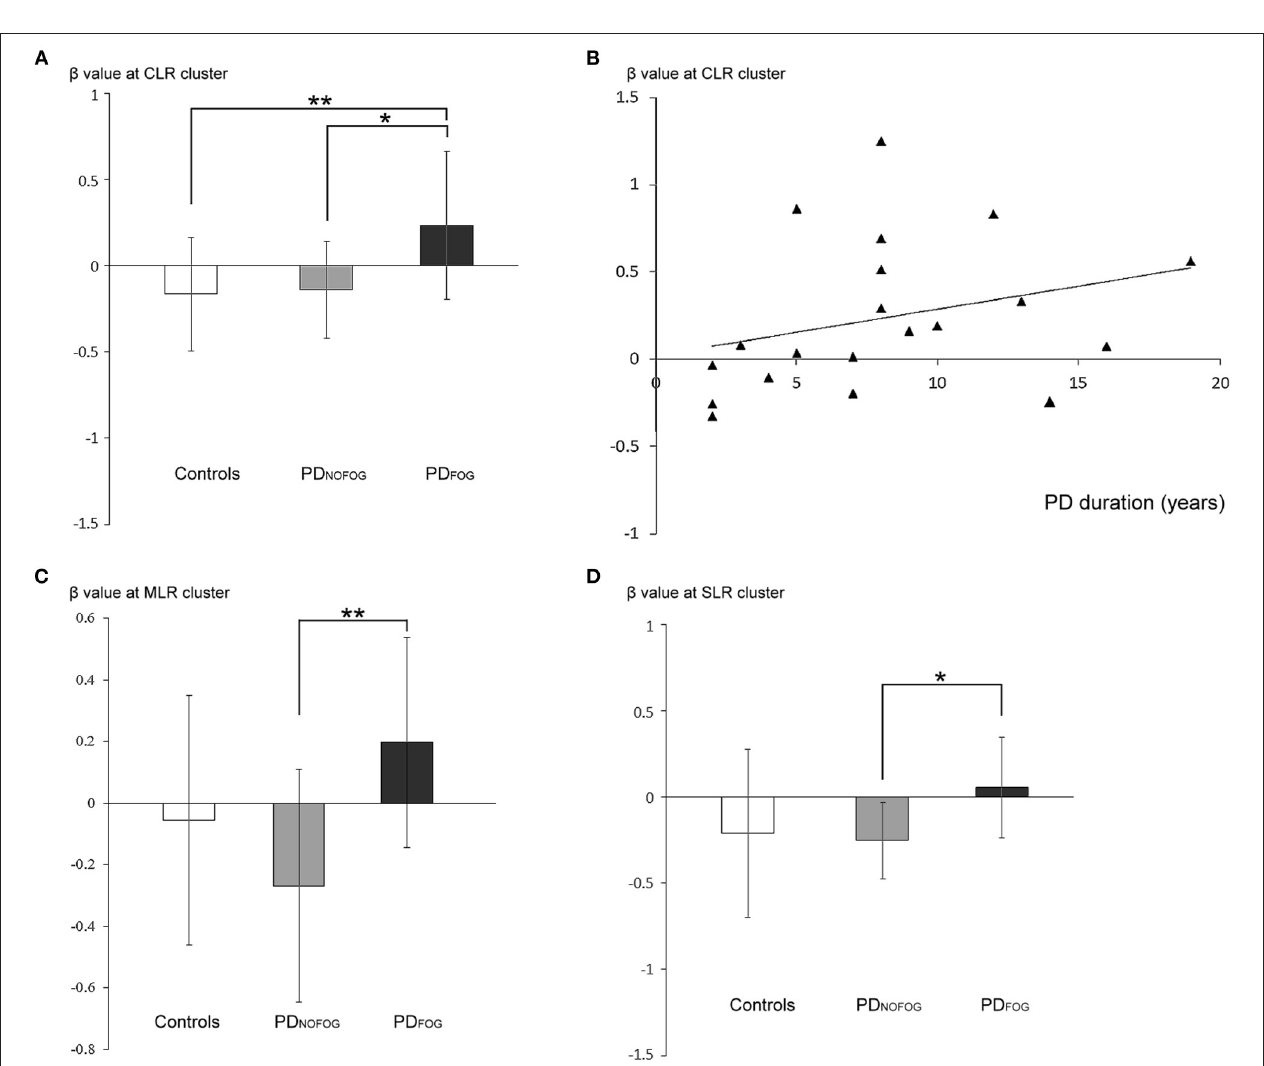
FIGURE 4 | (A) β -weights of the contrast between normal turning and standing (mean ± standard deviation) from the cerebellar locomotor region (CLR) clusters in normal controls, PD NOFOG , and PD FOG . (B) Scatterplots of β -weights at the CLR cluster (y-axis) against PD duration (x-axis; Spearman’s correlation ρ = 0.455, R 2 = 0.088, p = 0.044) during normal turning in PD FOG . (C) β -weights of the contrast between normal turning and standing (mean ± standard deviation) from the mesencephalic locomotor region (MLR) clusters in normal controls, PD NOFOG , and PD FOG . (D) β -weights of the contrast between normal turning and standing (mean ± standard deviation) from the subthalamic locomotor region (SLR) clusters in normal controls, PD NOFOG , and PD FOG . * p < 0.05, ** p < 0.01.